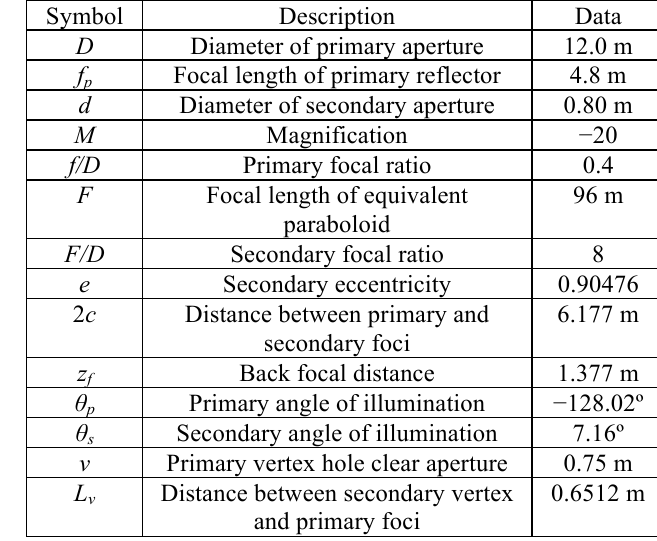
Table 5: Parameters for the on-axis Gregorian